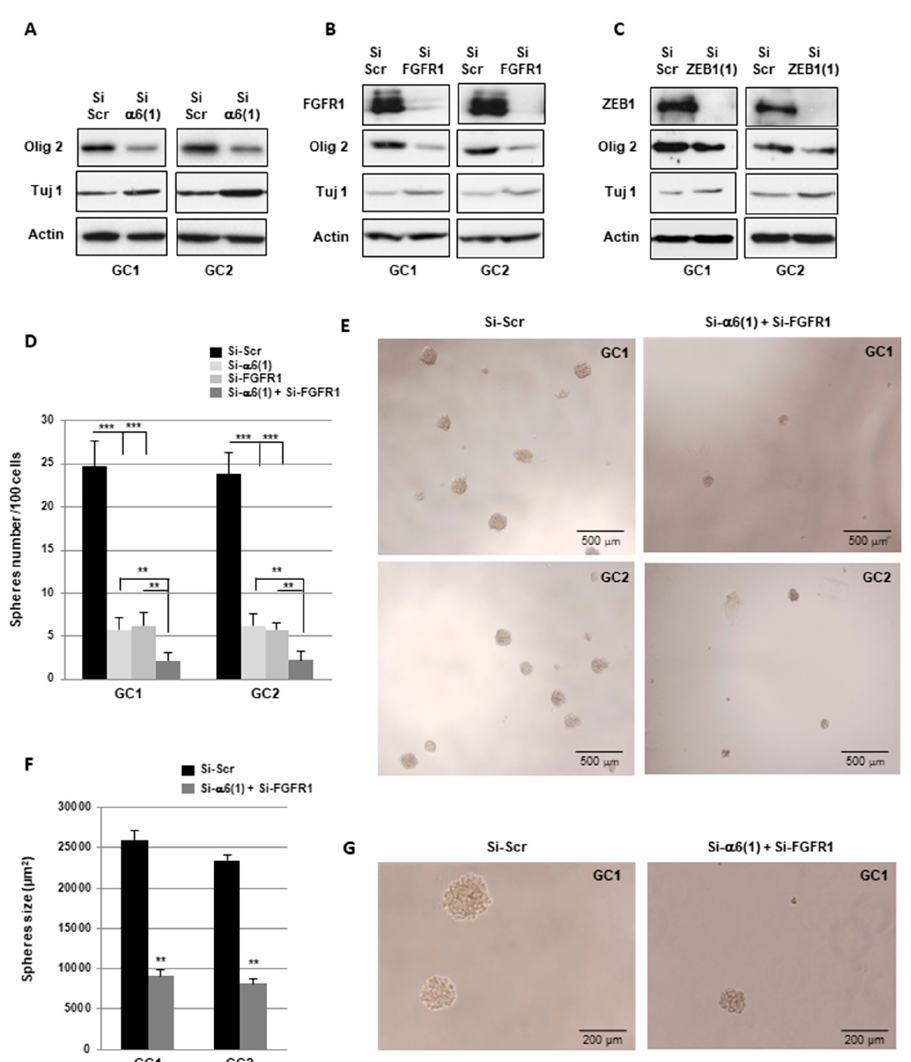
Figure 6. α 6-integrin and FGFR1 cooperate in GBMSC to regulate neurospheres formation and stemness. ( A – G ) GBMSC derived from GBM biopsy specimens (GC1, GC2) were transfected with an α 6-integrin siRNA (si- α 6 (1)), a FGFR1 siRNA (si-FGFR1), a combination of both siRNA (si- α 6 (1)